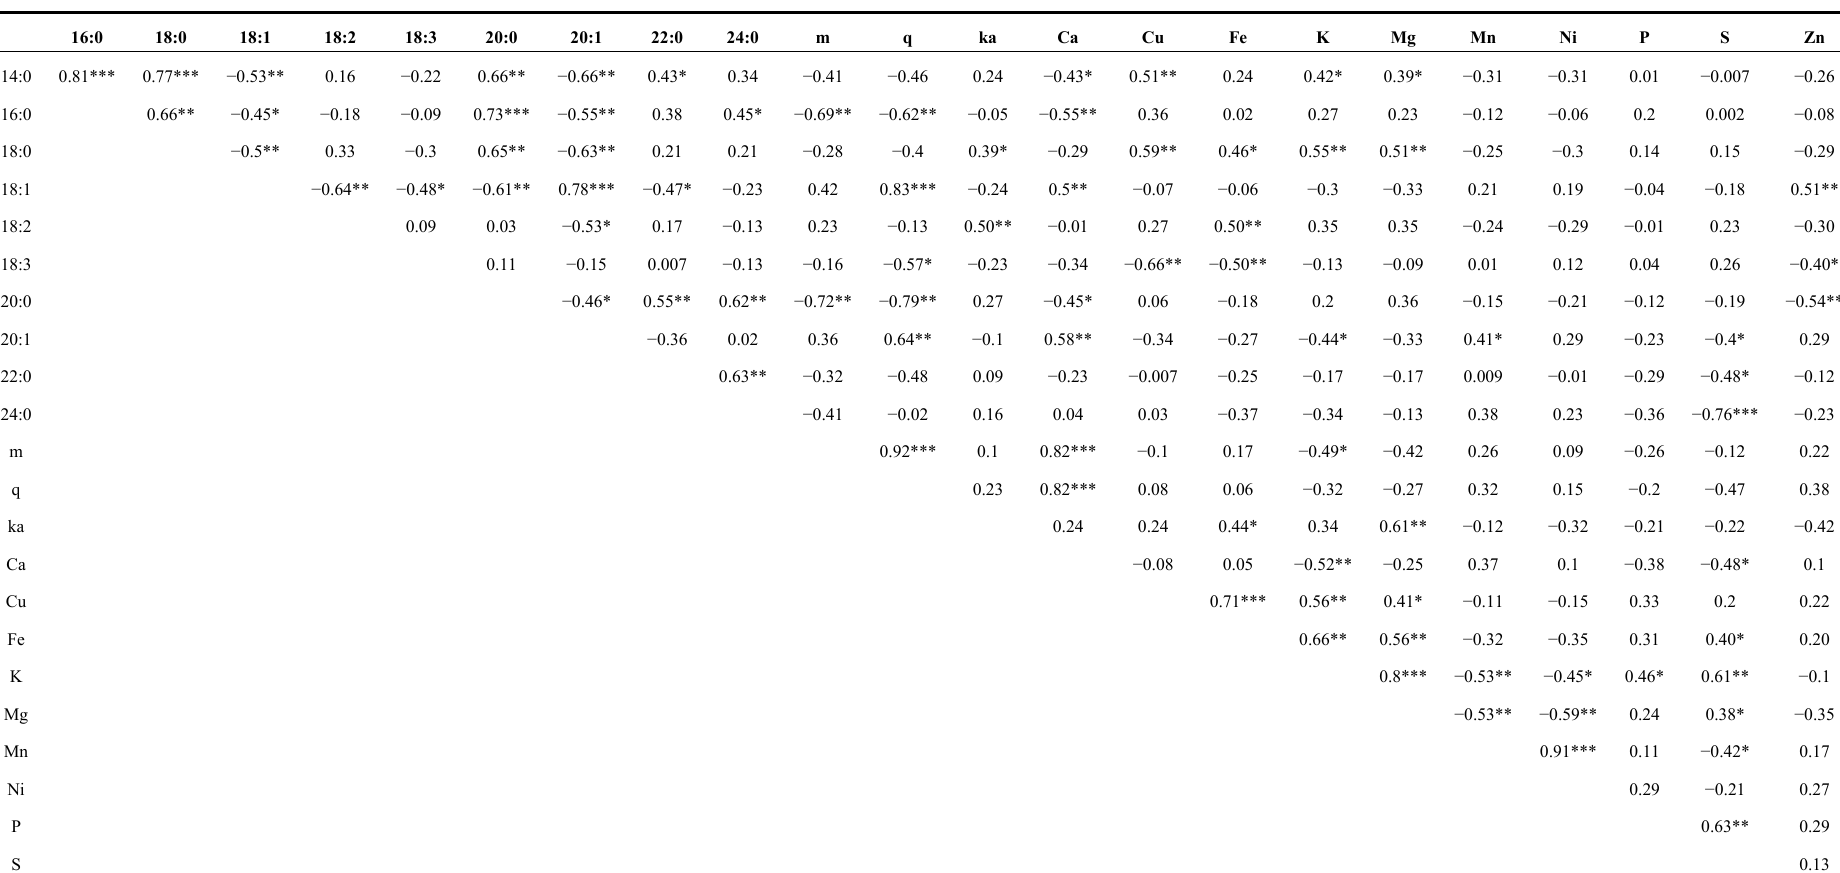
Table 7. Correlation coefficients (r) resulting from Pearson correlation analysis of the mean compositions of ten fatty acids, three flavonols, and ten minerals in seven horse gram accessions. Statistical significance of correlation coefficient is indicated †